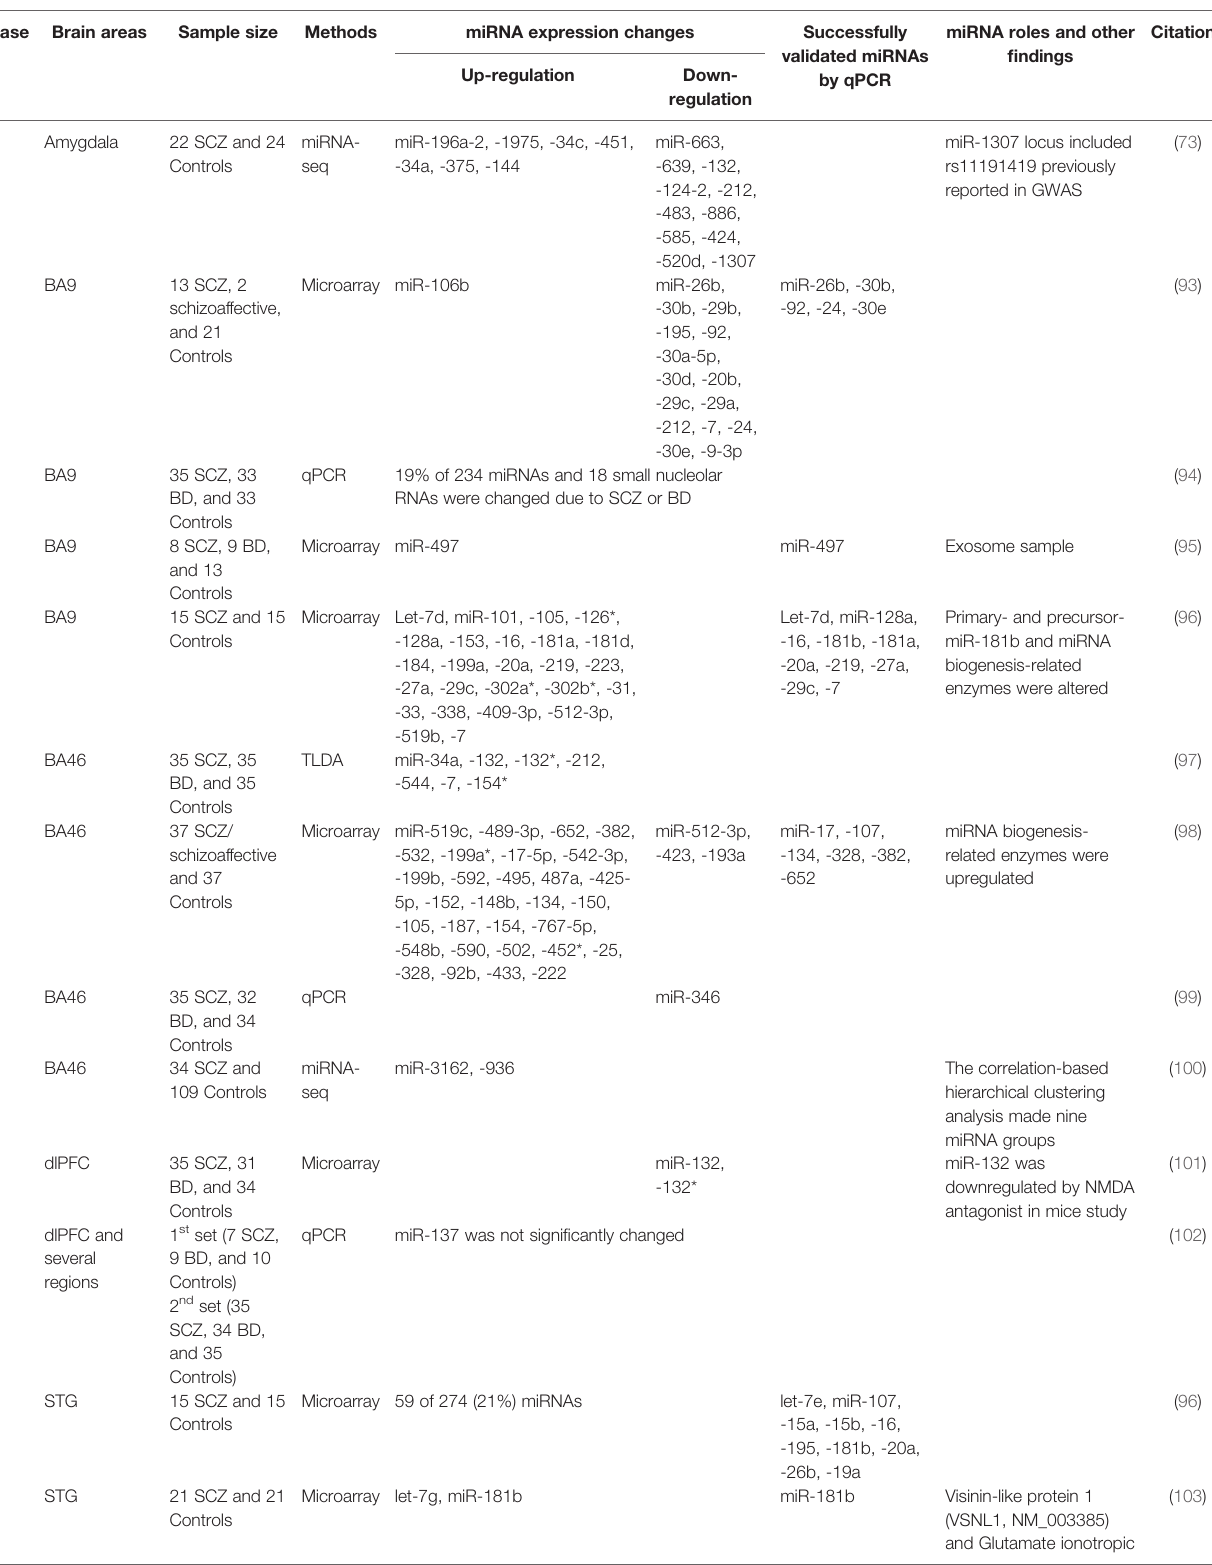
TABLE 3 | miRNA expression changes in psychiatric disorders based on postmortem brain studies. Disease Brain